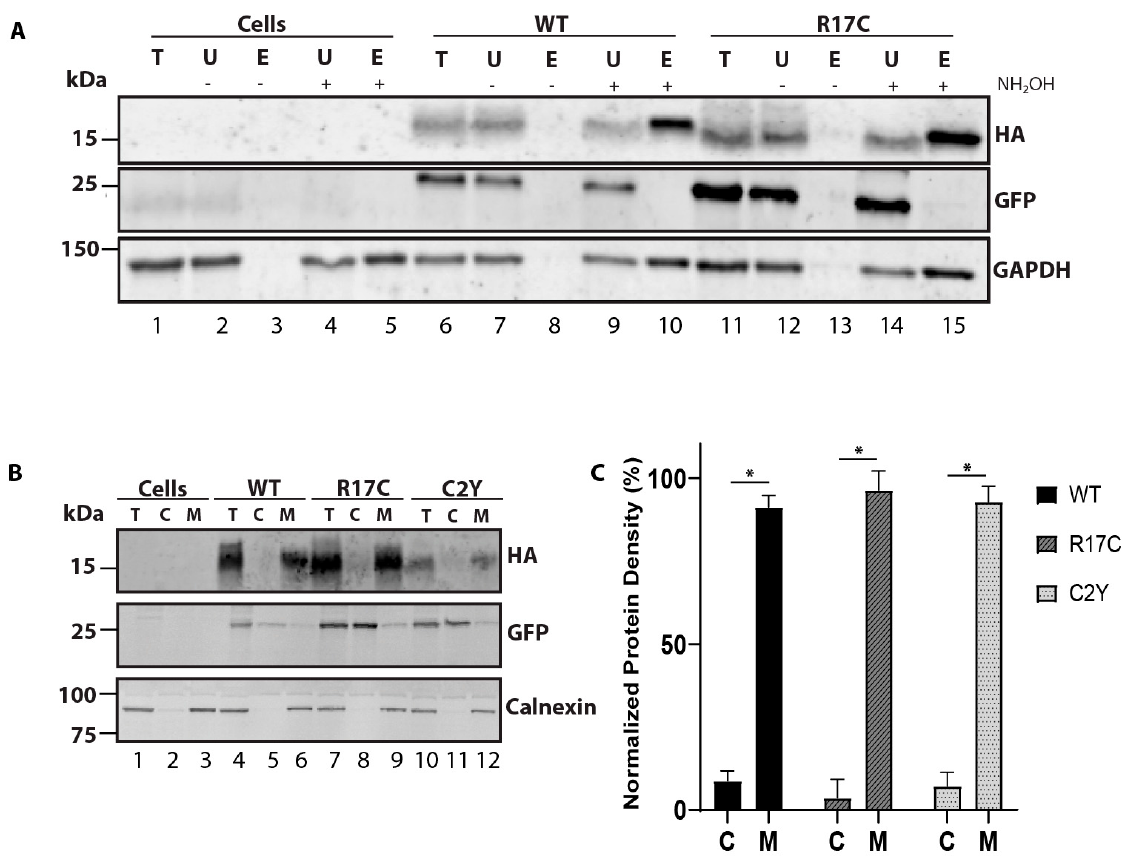
Figure 2. Mutation in the PBR region of PRCD does not affect protein palmitoylation and membrane association. ( A ) to assess the palmitoylation status of PRCD-R17C, the Acyl-RAC method was conducted with protein transiently expressed in hRPE1 cells. Immunoblots show both PRCD-WT and R17C are palmitoylated after treating with hydroxylamine (+NH2OH) (compare lanes 8 and 10 (WT); 13 and 15 (R17C)), whereas -NH2OH extracts were treated with vehicle control of water ( n = 3). Total (T), unbound (U), elute (E) protein fractions, -E (untreated with NH2OH), +E (treated with NH2OH). GFP serves as a negative control, and GAPDH serves as a known palmitoylated positive control. Non-transfected cells (lanes 1–5) are used as a control which does not express -tagged PRCD proteins. ( B ) isotonic protein extraction examining the associations of proteins with membranes. Fraction labeling is denoted by: total (T), cytosolic (C), and membrane (M). HA, PRCD protein tagged with HA-tag, GFP, a known cytosolic protein independently expressed under IRES in the same plasmid construct, and calnexin, a known membrane-bound protein, were used as controls. Each PRCD mutant protein shows strong membrane binding. ( C ) Protein density of each fraction was normalized to protein density found in the total protein fractions ( n = 3) with each mutant being significantly (* p < 0.05) bound to the